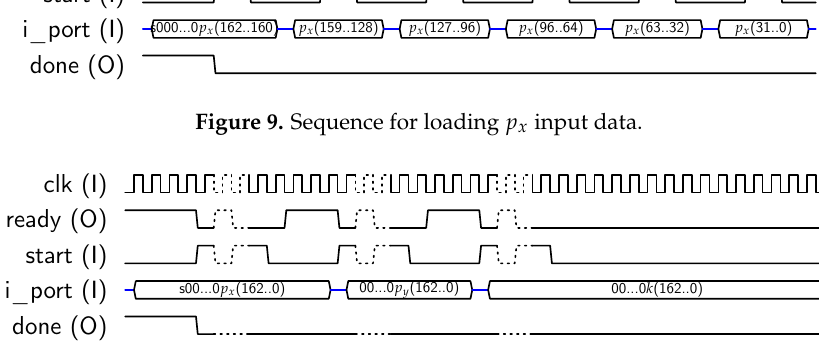
Figure 10. Sequence for loading p x , p y and k .